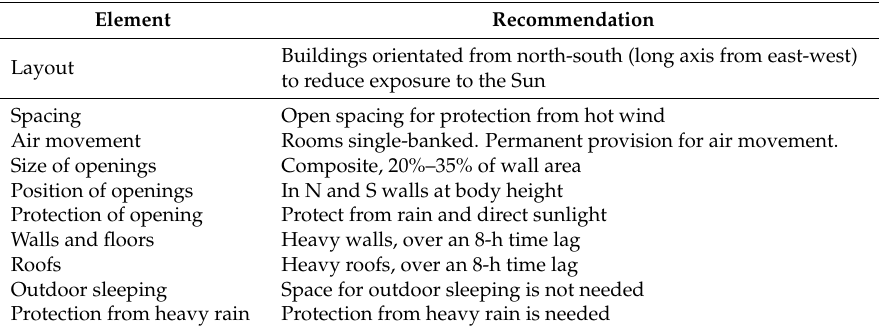
Table 13. Recommendation for building design in Jakarta.